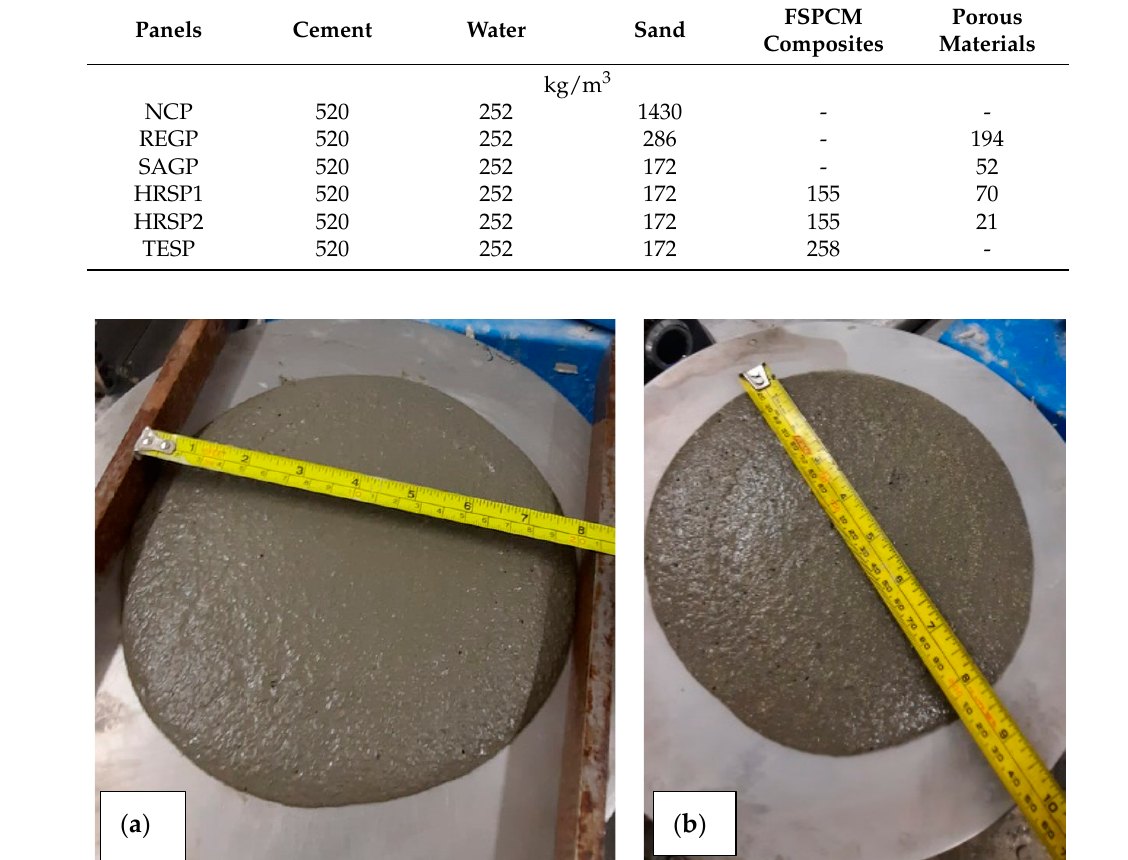
Figure 2. Workability of ( a ) SAGP and ( b ) HRSP. Table 1. Mix design recipe of developed panels.